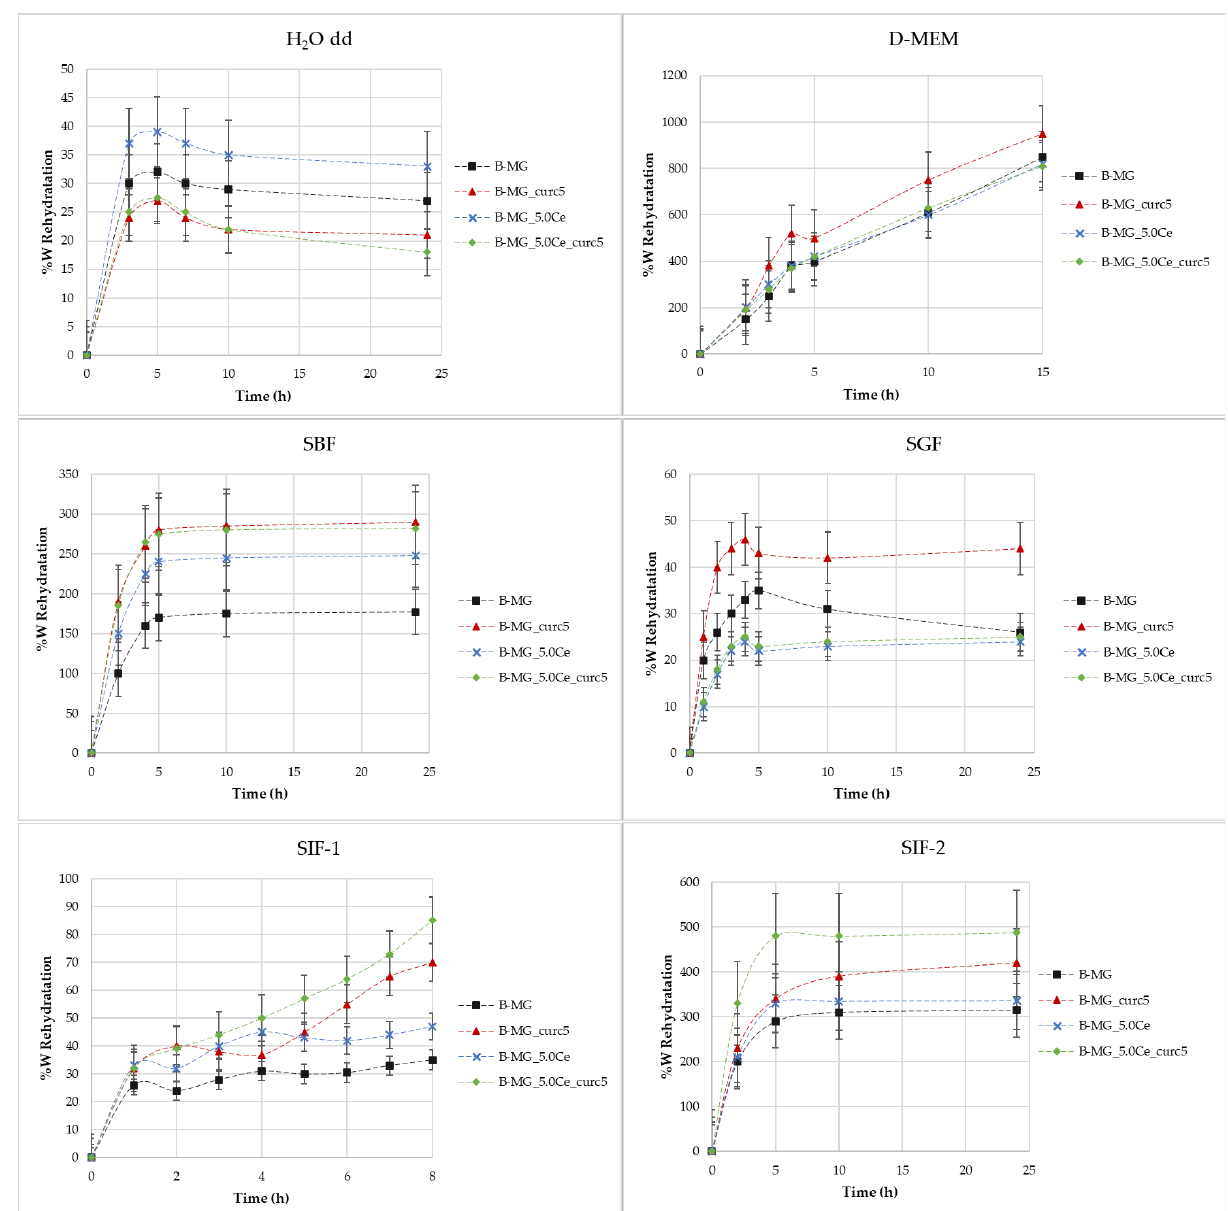
Figure 4. Rate of rehydration (%W) as a function of time in different media.